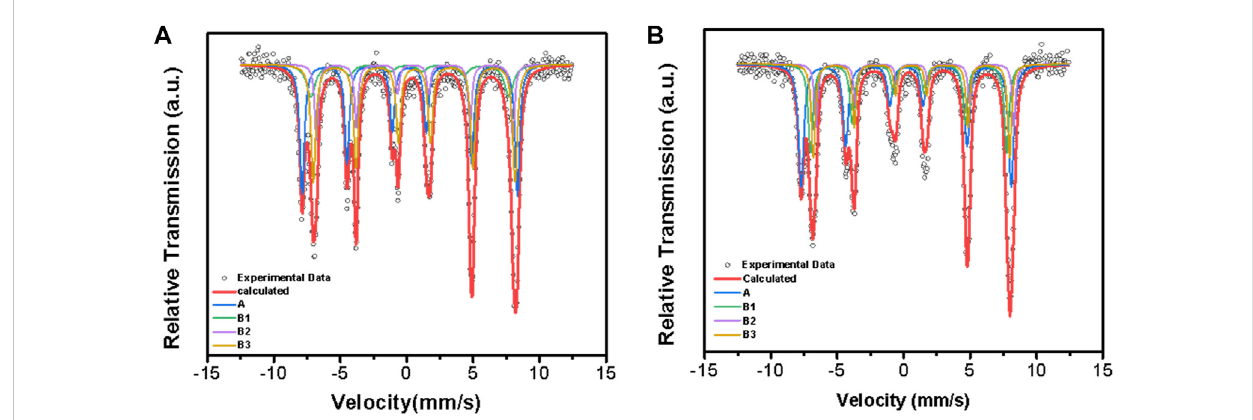
FIGURE 6 Room temperature Mössbauer spectra of Mag-25 (A) and Mag-700 (B) . The black circles stand for the experimental data, and the thick red line stands for the calculated data, Fe 3+ (A) sextet is shown in blue, Fe 3+ (B1), Fe 2+ (B2) and Fe 2+ (B3) sextets are shown in blue, green, purple and yellow, respectively.